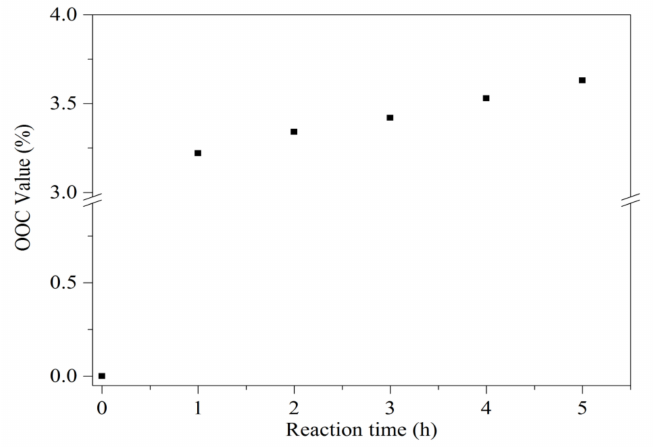
Figure 2. Oxirane oxygen content (OOC) value with time for the epoxidized jatropha oil